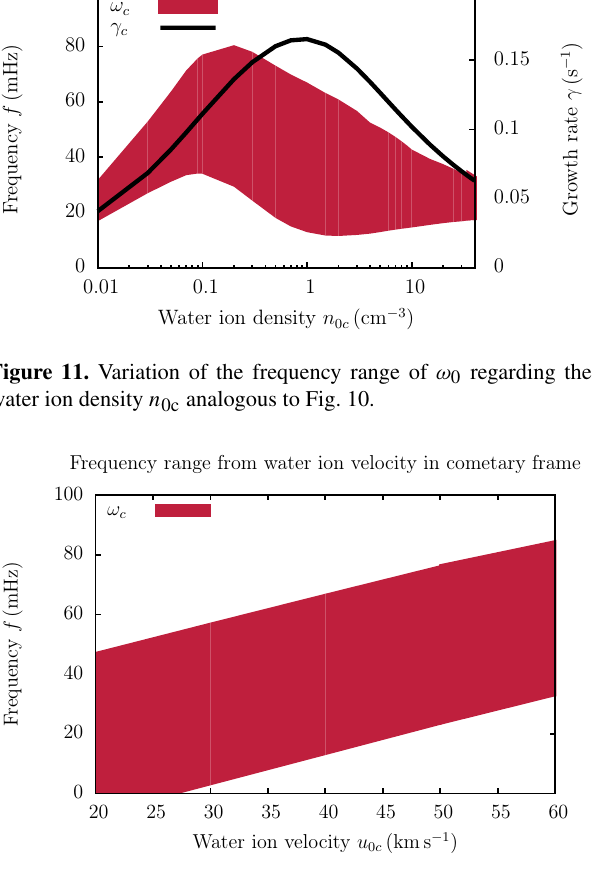
Figure 12. Variation of the frequency range of ω c regarding the water ion velocity u 0c analogous to Fig.